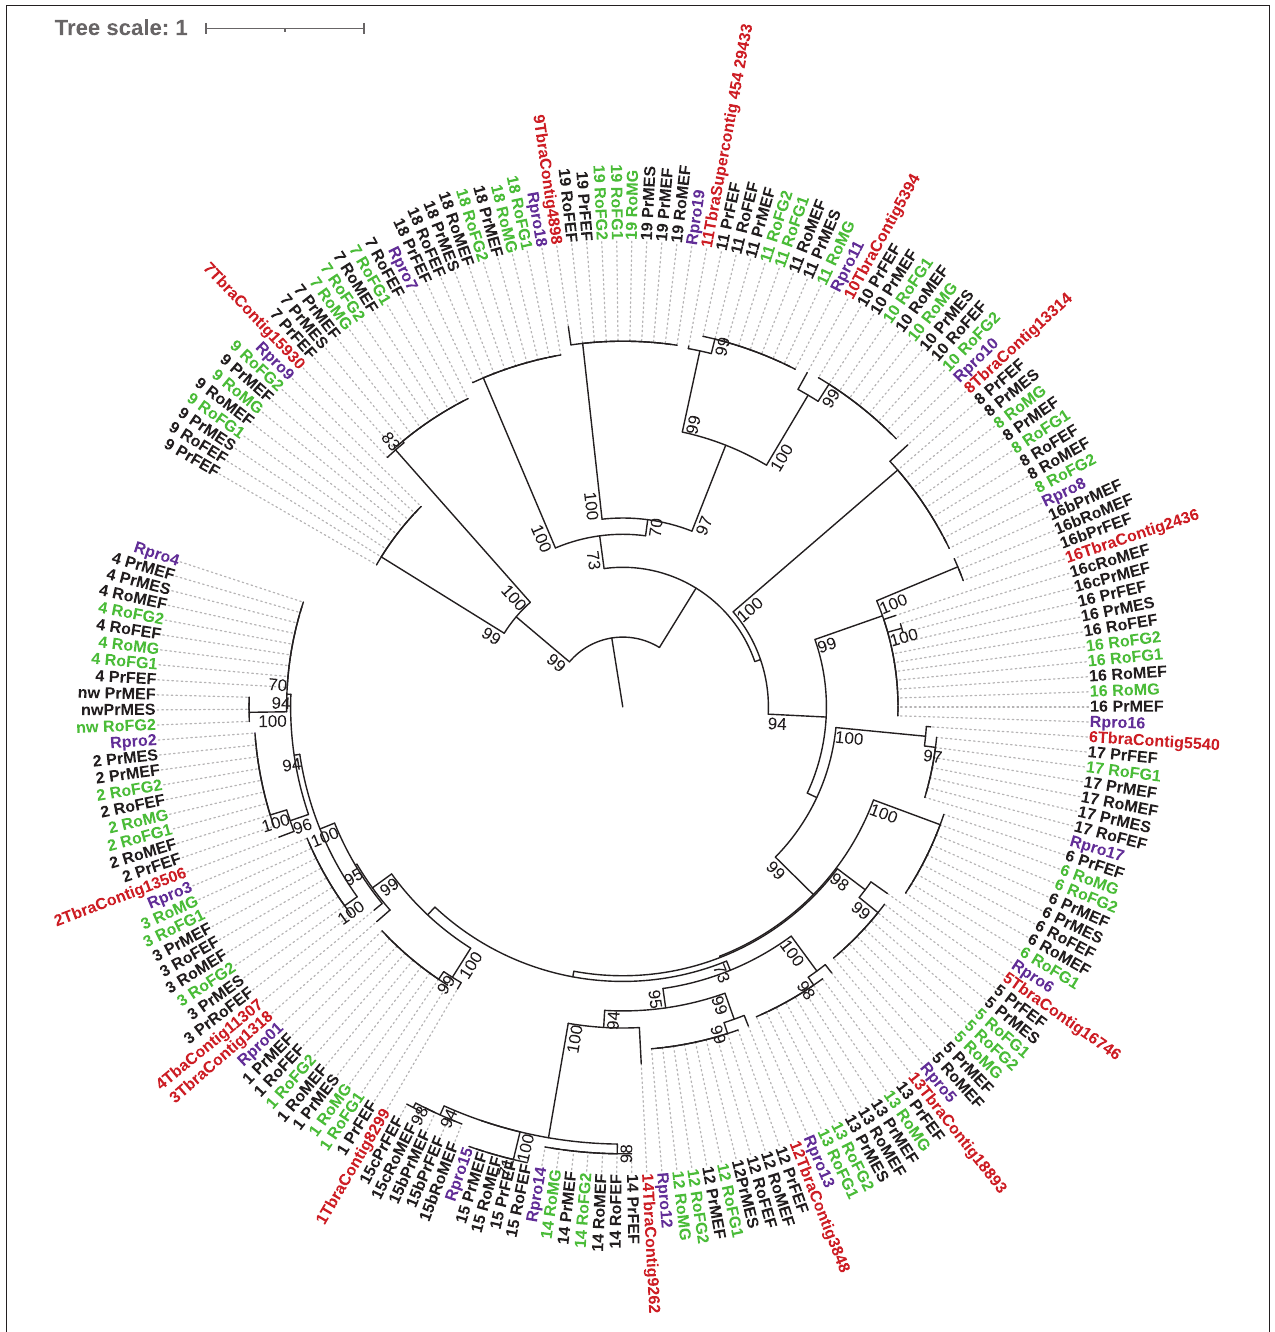
FIGURE 1 | Phylogenetic tree of chemosensory proteins (CSPs). Maximum likelihood tree in amino acids from the transcriptomic Rhodnius robustus and Rhodnius prolixus data sets (see Table 1 for sample labeling). Sylvatic R. robustus is indicated in green. The predicted R. prolixus protein genes (Mesquita et al., 2015) are indicated in purple and Triatoma brasiliensis transcripts (Marchant et al., 2016a) are indicated in red. A bootstrap > 70% is indicated on the